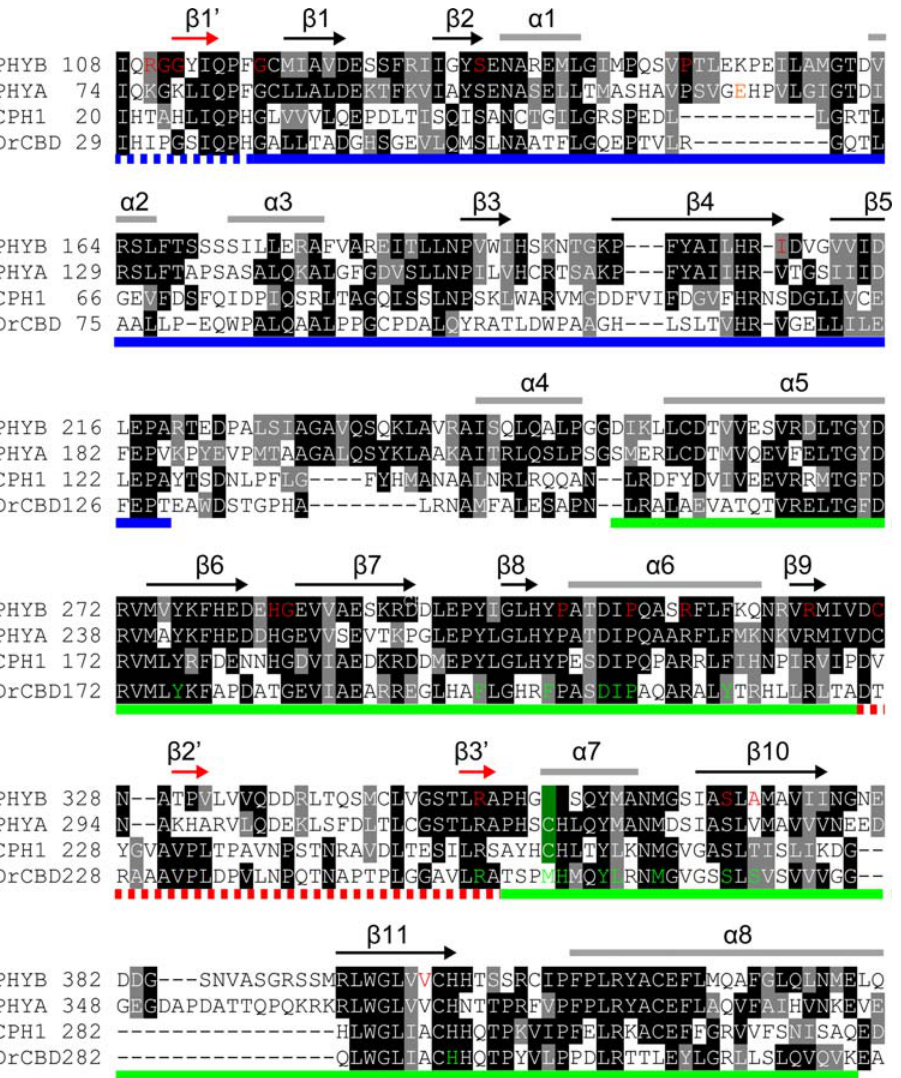
Figure 5. Alignment of Arabidopsis and Bacterial Phytochrome Sequences. The PLD-GAF region of phytochrome sequences are aligned. PHYB, Arabidopsis thaliana phyB; PHYA, Arabidopsis thaliana phyA; CPH1, Synechosystis PCC6803 Cph1; DrCBD, Deinococcus radiodurans BphP. Arrows and short bars on top of the sequences represent b -strands and a -helices, respectively. Blue and green lines at the bottom indicate PLD and GAF, respectively. Domains were delimited as for Figure 1A. A broken red line indicates the loop extended from GAF, which forms the light sensing knot together with the N-terminal end of PLD (broken blue). In the knot structure, the b 1 9 , b 2 9 and b 3 9 strands (red arrows) form a small b -sheet. Amino acid residues at which mutations were found are indicated in red. The cysteine residues that bind the chromophore are indicated by green background. Amino acid residues that are in direct contact with the chromophore in Dr CBD are indicated in green. The three dimensional structure is based on